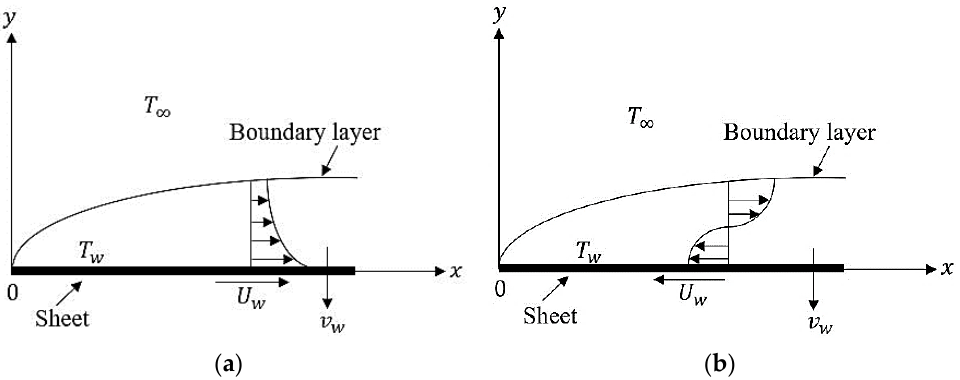
Figure 1. Physical model for: ( a ) Stretching sheet ( λ > 0); ( b ) Shrinking sheet ( λ < 0) [44].